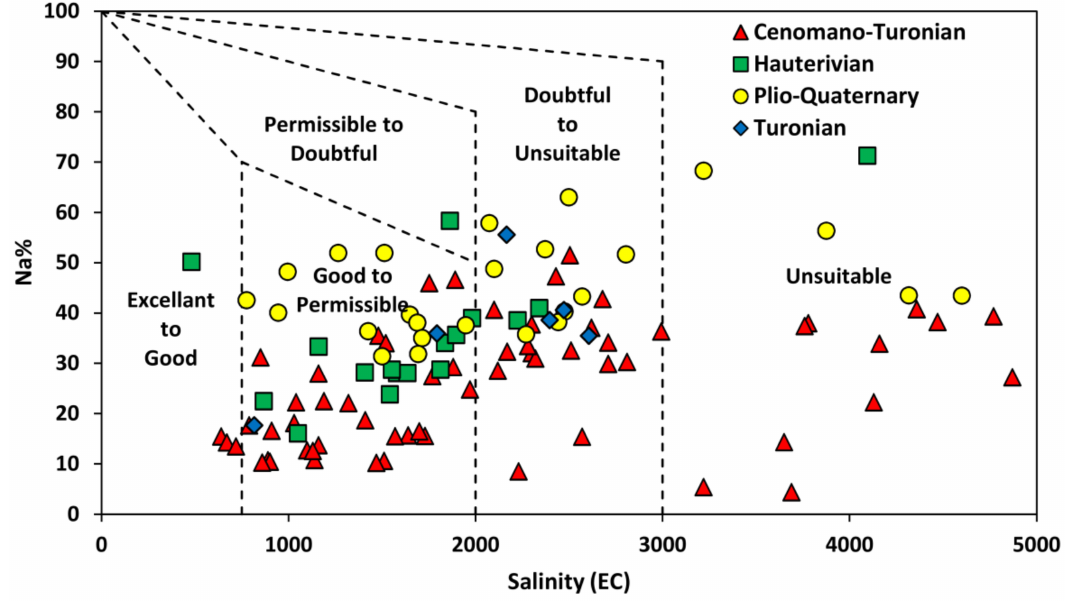
Figure 17. Wilcox diagram of the analyzed samples.